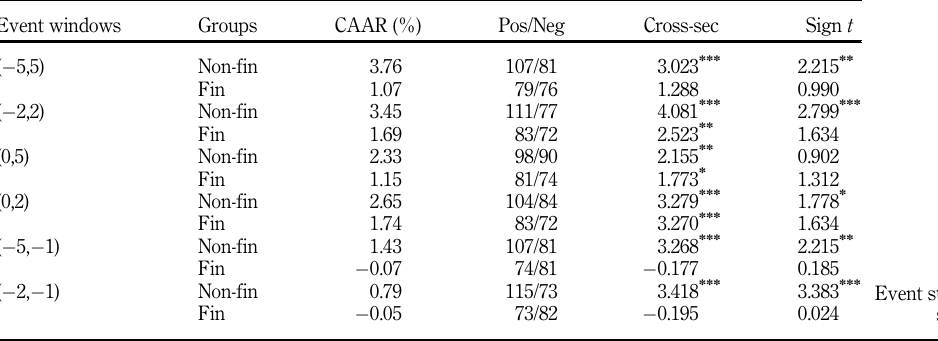
Table 9. Event study results